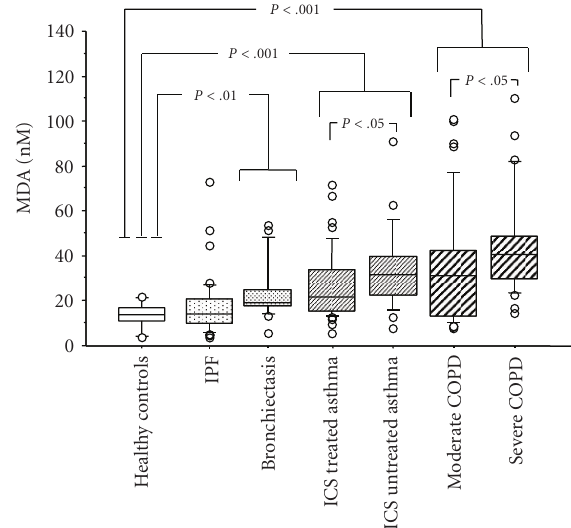
Figure 3: Median values (interquartile range) of malondialdehyde (MDA) in EBC in the di ff erent categories of patients with dif- ferent pulmonary diseases and healthy subjects; IPF: Idiopathic pulmonary fibrosis; ICS: inhaled corticosteroids; COPD: chronic obstructive pulmonary